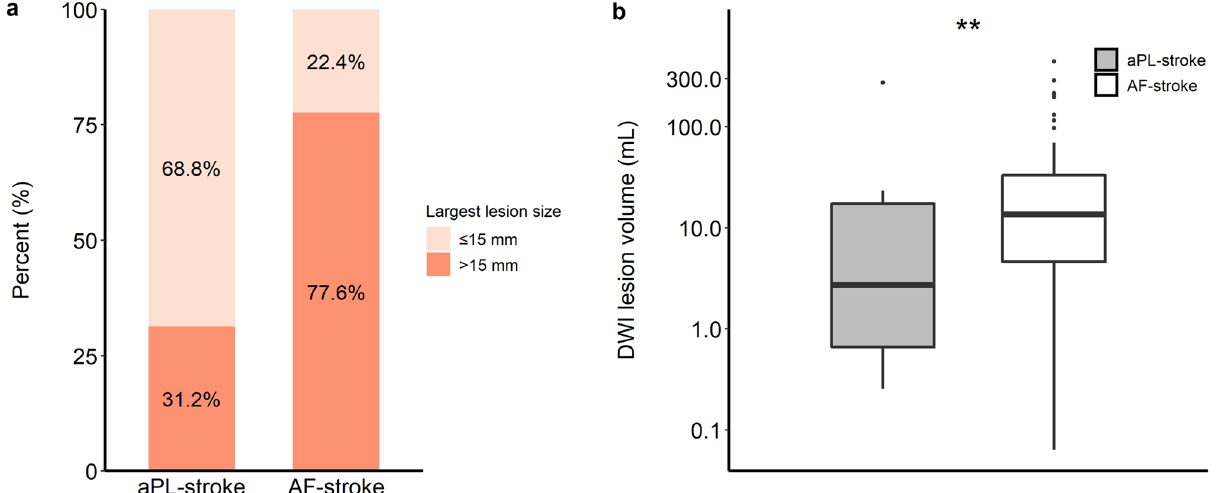
Figure 4. DWI lesion pattern and total lesion volume of aPL- and AF-stroke patients with a multi-territory lesion. ( a ) Lesion pattern based on the largest lesion size (≤ 15 mm or > 15 mm) of aPL- and AF-stroke patients with multi-territory lesions. ( b ) Total DWI lesion volumes of aPL- and AF-stroke patients with multi-territory lesions. DWI lesion volume is presented on the y-axis as a log scale. ** p < 0.01. AF-stroke atrial fibrillation- related stroke, aPL-stroke antiphospholipid antibody-related stroke, DWI diffusion-weighted